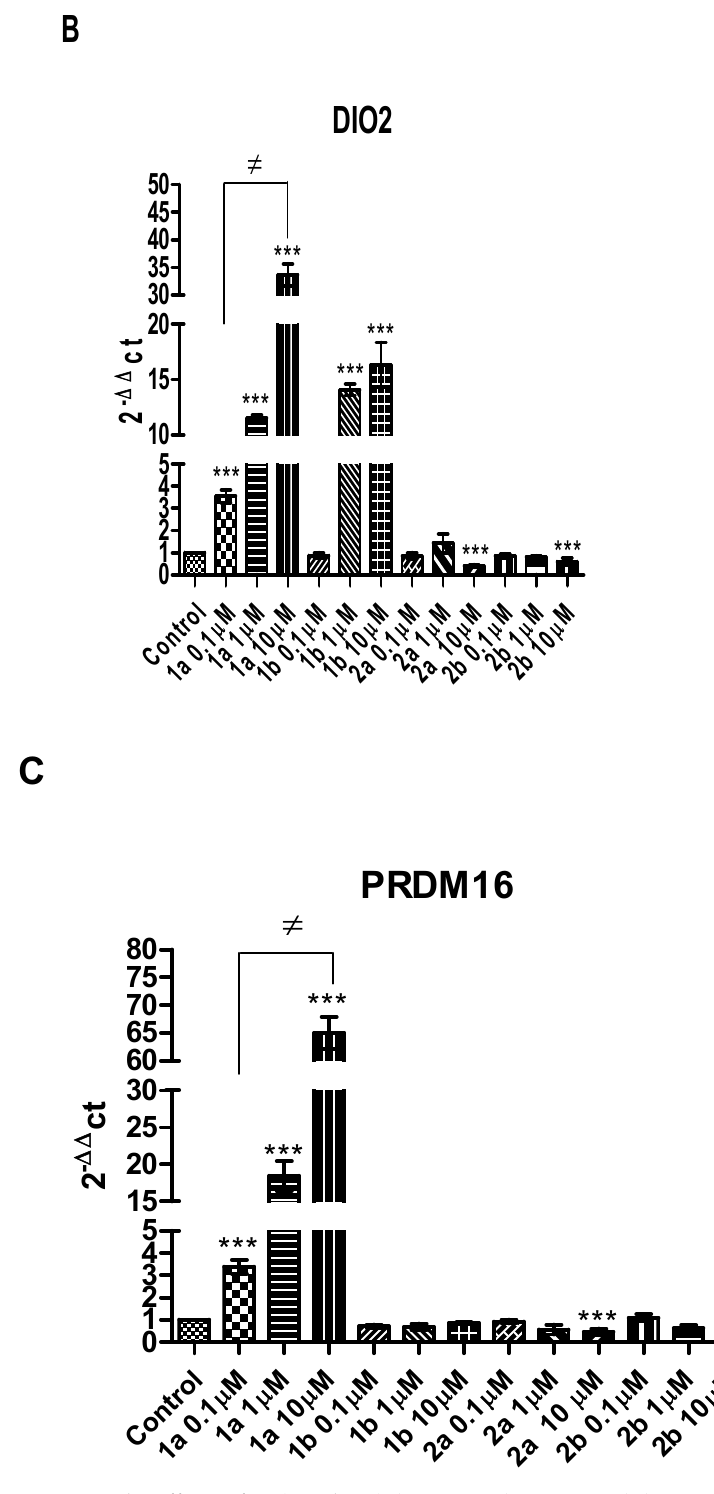
Figure 7. The effects of 1a − b and 2a − b (0.1 − 10 μ M), on UCP1 ( A ), PRDM16 ( B ), and DIO2 ( C ), gene expression in white adipocytes. Data were reported as means ± SEM. The results were analyzed by analysis of variance (ANOVA) followed by the Newman–Keuls post ‐ hoc test. ANOVA, p < 0.0001; post ‐ hoc *** p < 0.001 vs. control group; ≠ p < 0.05 vs. 1a (0.1,1 μ M); ≠ p < 0.05 vs. 1b (0.1,1 μ M).